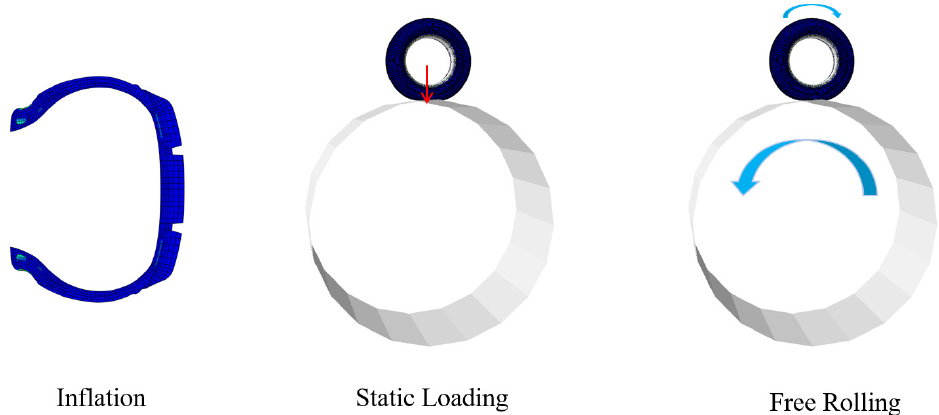
Figure 13. Steady-state rolling analysis procedure.